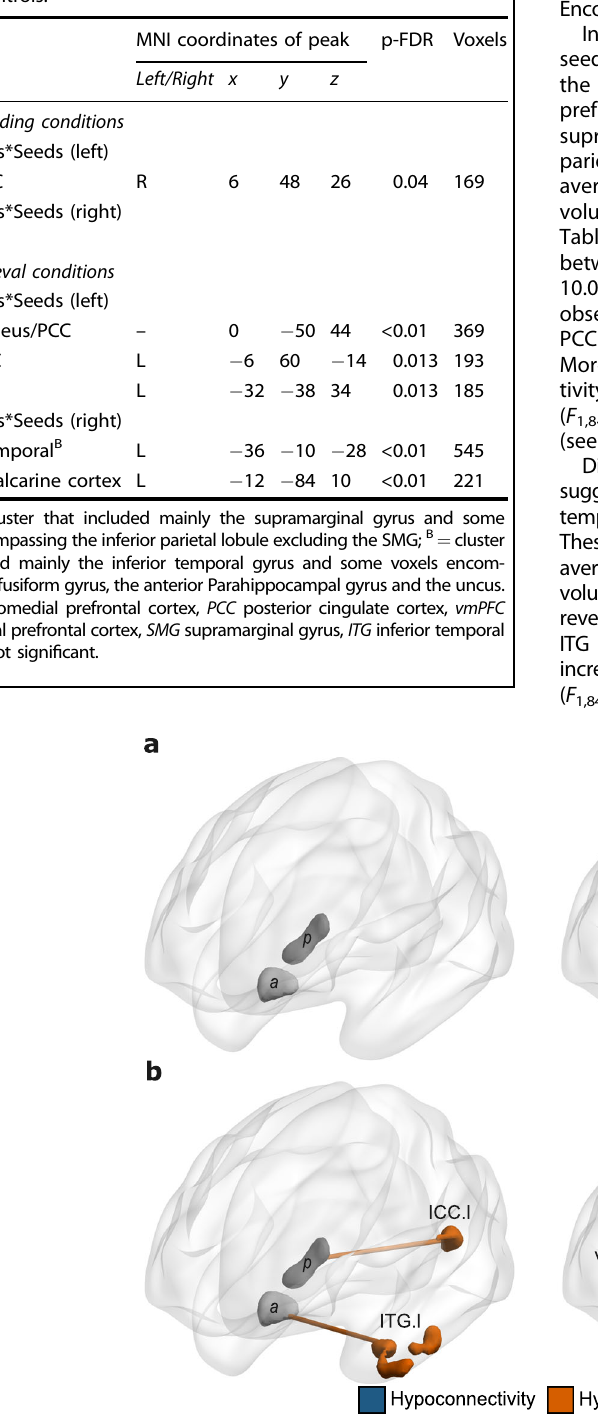
Fig. 1 Brain regions (targets) showing signi fi cant between-group differences in connectivity with hippocampal subregions from the diagnosis-by-seeds interactions. a Results from the diagnosis-by-seeds of the left hemisphere in the encoding condition. b Results from the diagnosis-by-seeds in the retrieval condition; blue connections/regions indicate signi fi cant hypoconnectivity with the target; orange connections/regions indicate signi fi cant hyperconnectivity with the target. a anterior hippocampus, p posterior hippocampus, vmPFC ventromedial prefrontal cortex, ICC intracalcarine cortex, dmPFC dorsomedial prefrontal cortex, PCC posterior cingulate cortex, SMG supramarginal gyrus, ITG inferior temporal gyrus, L/l left, R/r